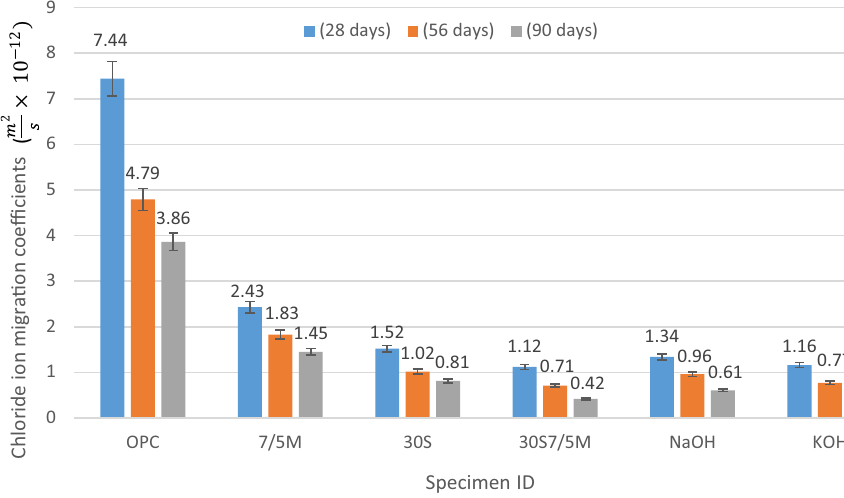
Fig. 13 The chloride ion migra- tion coefficients measured by RCMT